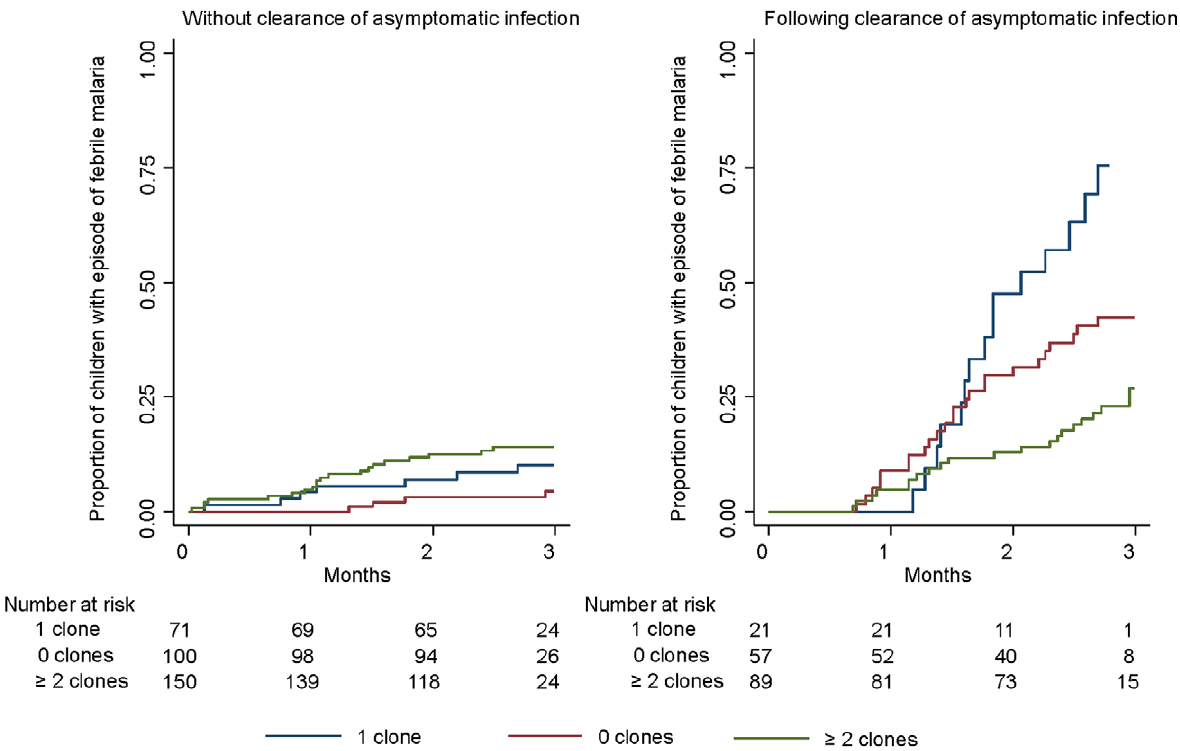
Figure 4. Kaplan Meier estimate of time to subsequent clinical episode with treatment excluding children who remained uninfected during follow-up.